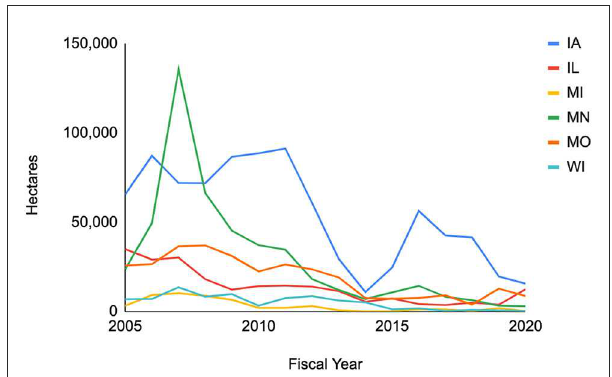
FIGURE5 New Conservation Reserve Program contracts each year by area. Data Source: USDA-NRCS, National Planning and Agreements Database (USDA Natural Resources Conservation Service,